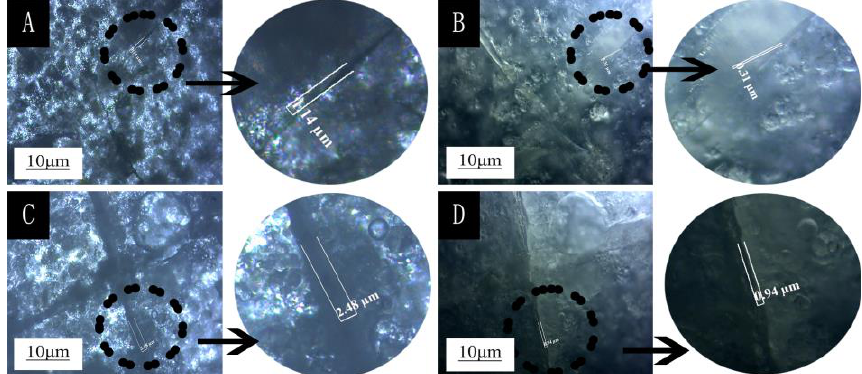
Figure 14. Effect of different microcapsule mass fractions on the repair effect of the paint film: ( A ) and ( B ) are the paint film before and after repairing with the microcapsule mass fraction of 5.0%; ( C ) and ( D ) are the paint film before and after repairing with microcapsule mass fraction of 10.0%.